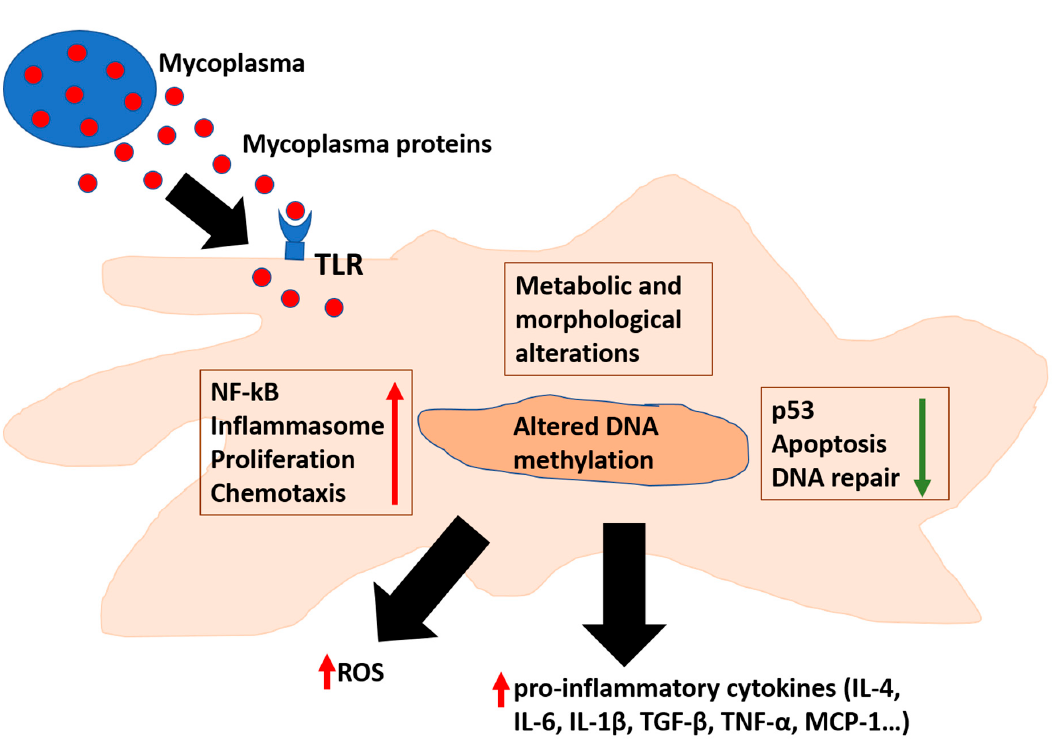
Figure 1. Mycoplasmas a ff ect cellular pathways involved in inflammation and cellular transformation. Mycoplasmas’ proteins interact with TLR or enter the cells, where they can alter several pathways responsible for inflammation and DNA repair. In addition, a ff ecting methylation of cellular DNA results in alteration of cellular epigenetic landscape. TLR: Toll Like Receptor; ROS: Reactive Oxygen Species. TGF: Transforming Growth Factor; TNF: Tumor Necrosis Factor; and MCP-Monocyte Chemoattractant Protein.